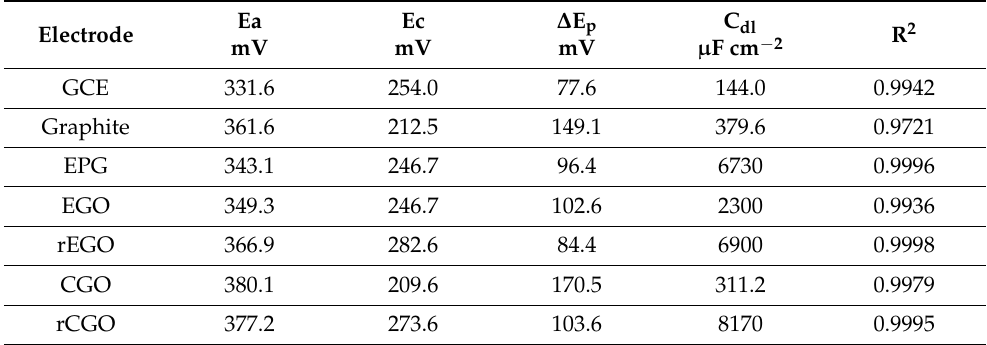
Table 2. Comparison of electrochemical results of the GCE substrate, graphite, EPG, EGO, rEGO, CGO and rCGO.